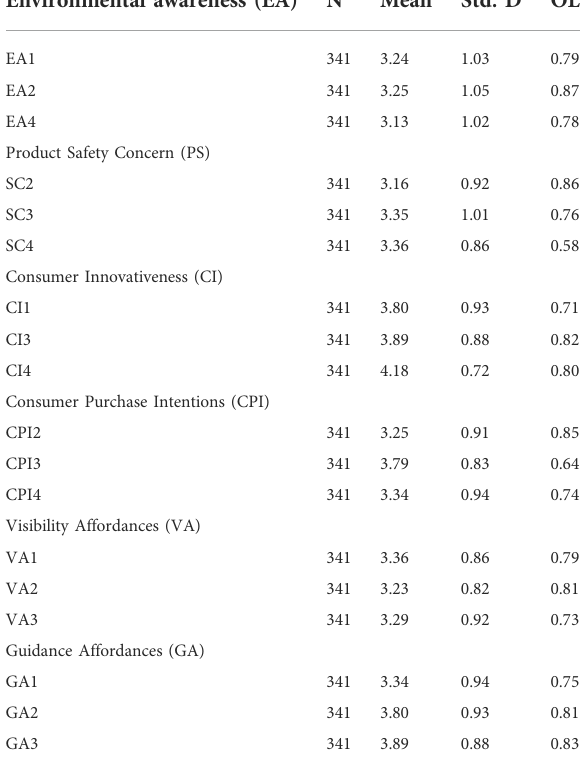
TABLE 2 Constructs with outer loading values